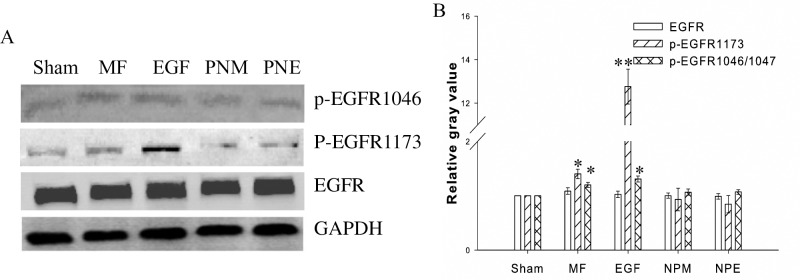
MF activated EGFR.A: Western blot of EGFR and EGFR phosphorylation at residue Tyr1173 and Ser1046; B: relative gray value/content of the proteins to the Sham groups after normalized with the GAPDH content, * and **: p-value < 0.05 and < 0.01 when compared with Sham by Student’s t-test, respectively. The groups were treated as described in Fig 1 and in Materials and Methods.